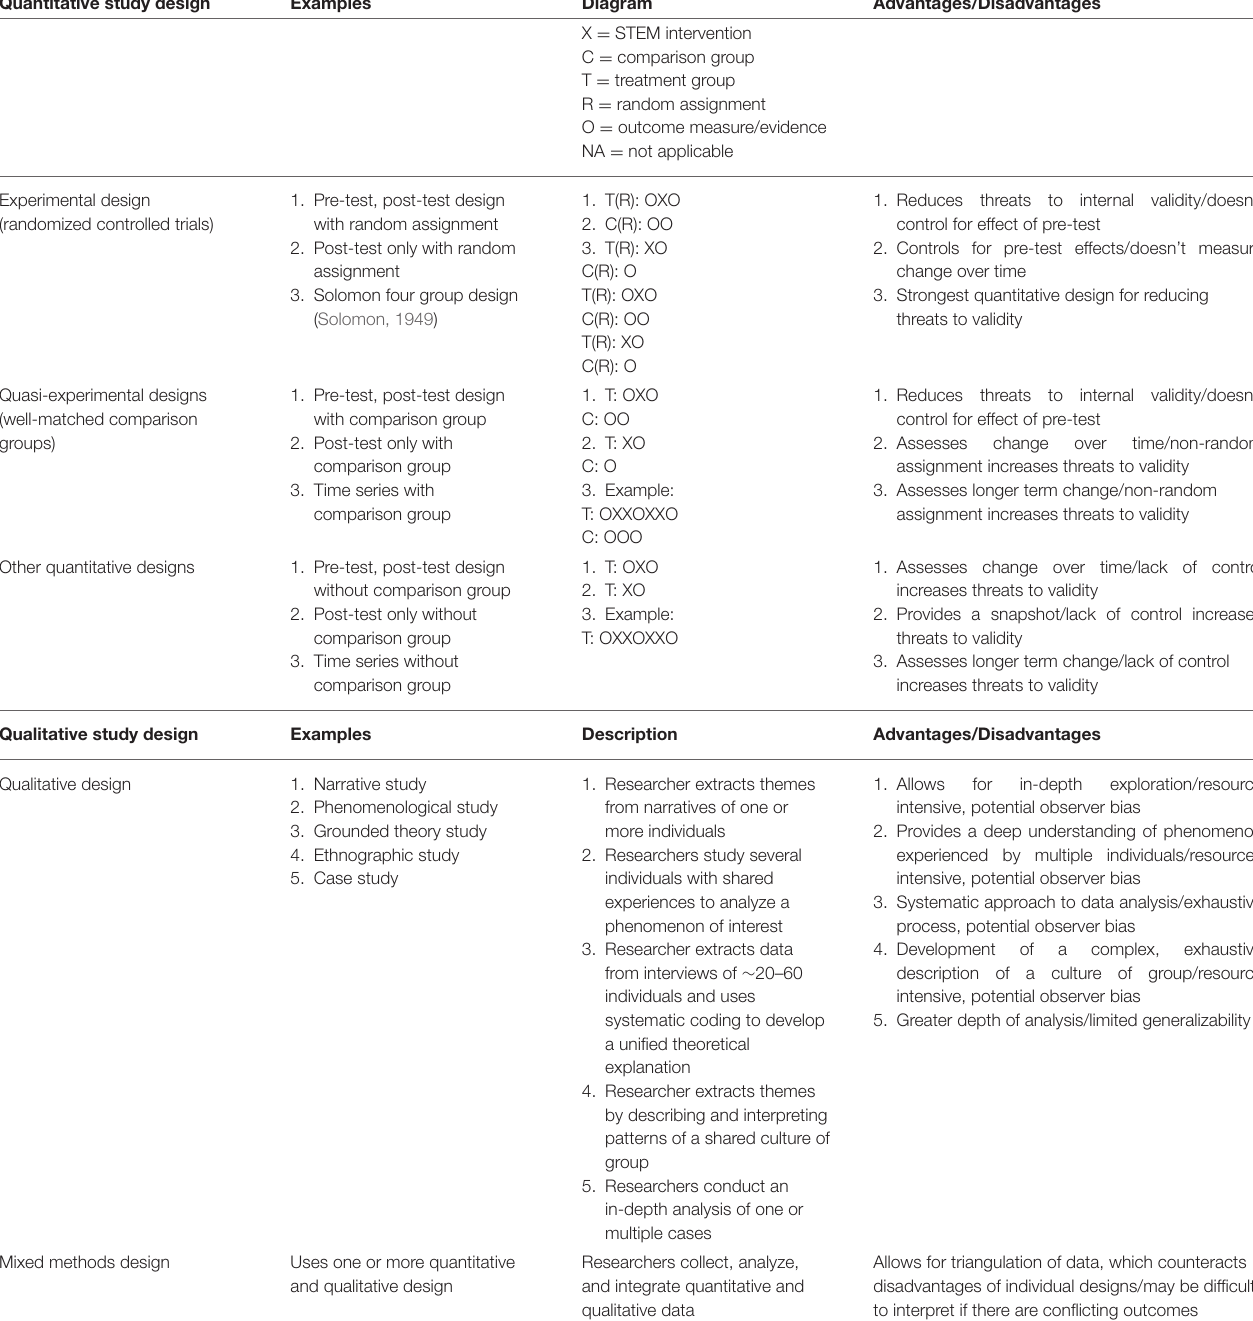
TABLE 1 | Study designs for assessing the effectiveness of a STEM intervention. Quantitative study design Examples Diagram Advantages/Disadvantages